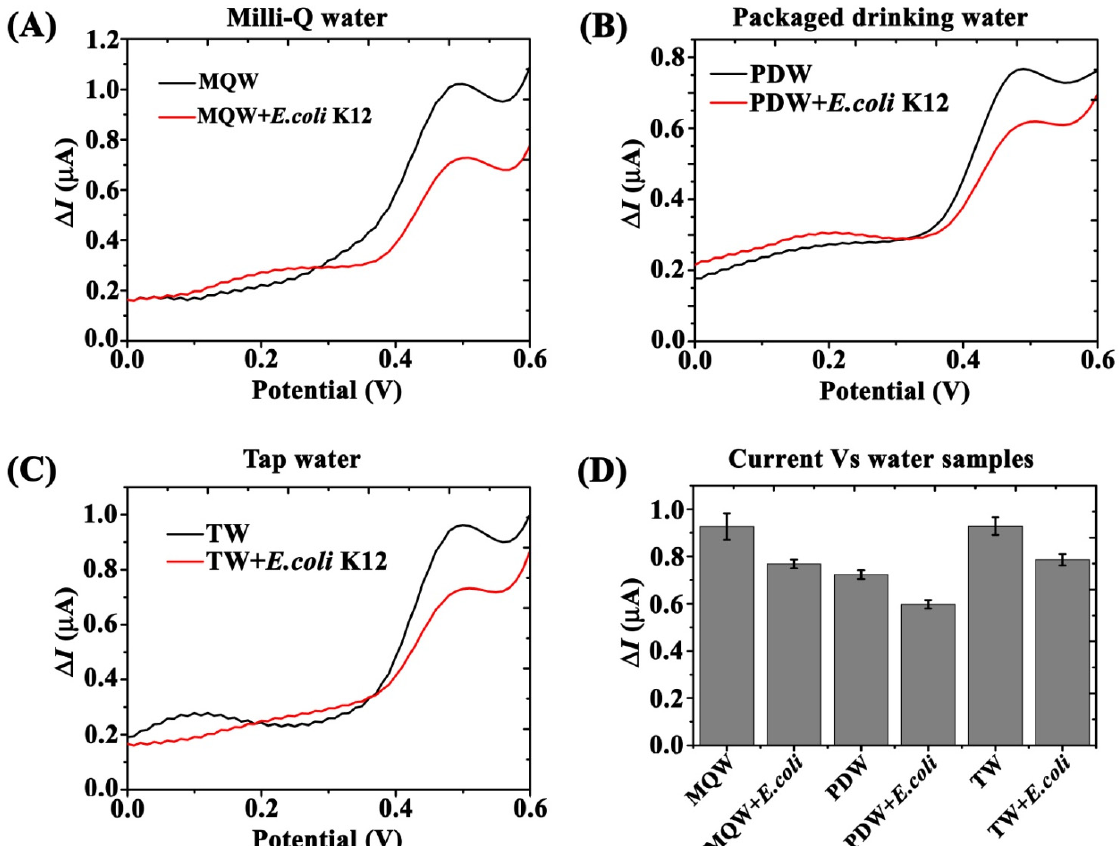
Figure 9. Electrochemical detection of E. coli K12 in different water samples using bi-functional Fc- MNP-IgG conjugate. SWV detection of E. coli K12 from Milli-Q water-MQW ( A ), Packaged drinking water-PDW ( B ), and Tap water-TW ( C ), with (red curves) and without (black curves) E. coli K12. ( D ) Bar graph indicates the measured Fc current signals from three different water samples. Error bars indicate the standard error of the means. SWV parameters: amplitude 0.1 V; scan increment 0.01 V; frequency 20 Hz and duration 4 s.